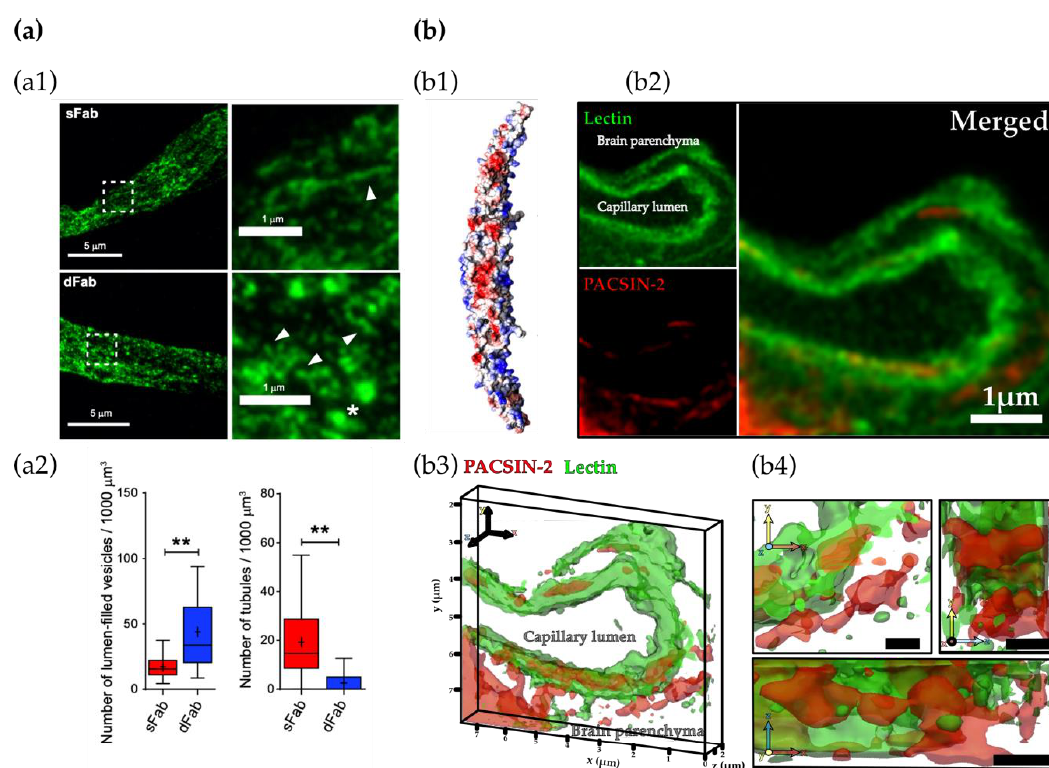
Figure 2. Tubulation as a mechanism of transport across the brain endothelium. ( a ) Transport of transferrin receptor-based brain shuttle constructs that are engineered by fusing a single-chain Fab fragment of an anti-transferrin monoclonal antibody to either one (monovalent, sFab) or both C-terminal ends (bivalent, dFab) across the brain endothelium. ( a1 ) Representative images of mouse brain capillary with brain shuttle platform based on sFab or dFab (green). Arrowheads point to an individual tubule for sFab and short elongated buds for dFab. Star shows vesicles with a dFab signal within the lumen. ( a2 ) Number of lumen-filled vesicles and tubules for sFab and sFab in segments of brain capillaries revealing the di ff erential transport along intracellular tubules in vivo. Permission from [6]. ** represents the statistical significance between sFab and dFab. ( b ) Tubulation in mouse brain endothelial cells (BECs) mediated by PACSIN-2. ( b1 ) Structure of PACSIN-2. Permission from [121]. ( b2 ) Section of brain capillary stained by lectin (in green) and PACSIN-2 (red) imaged by stimulated energy depletion (STED) microscopy and ( b3 ) corresponding 3D rendering showed as projection and ( b4 ) close-up from top, bottom and side view. Adapted from